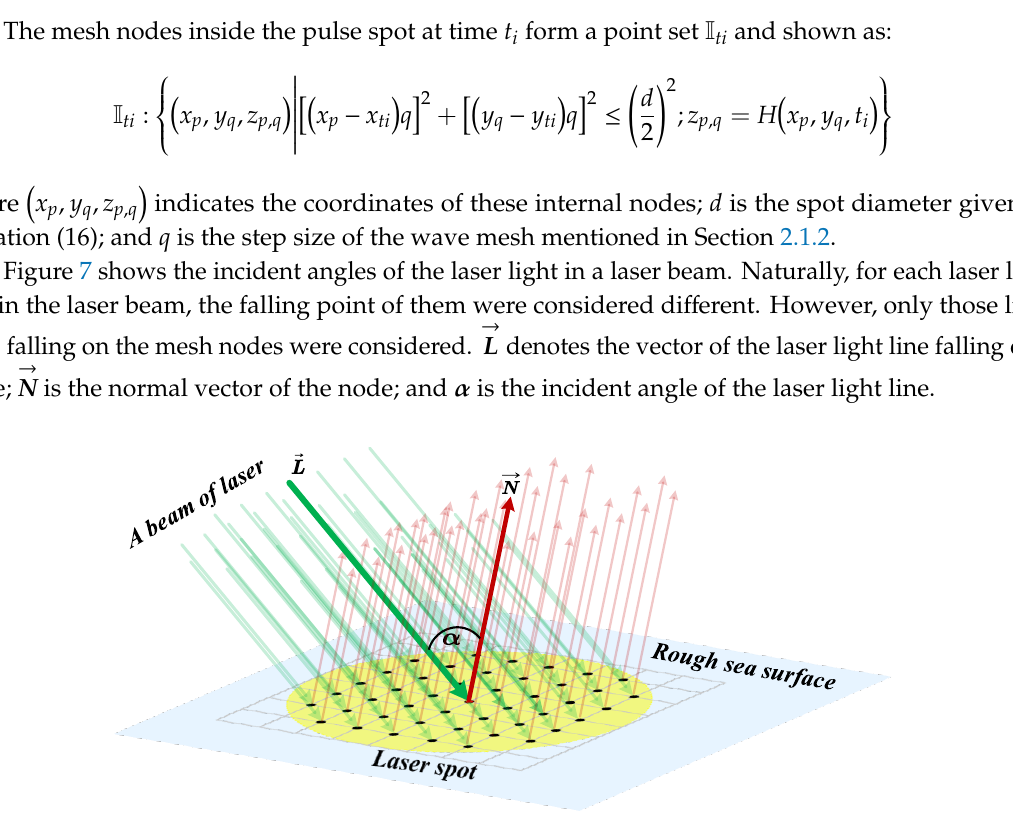
Figure 6. Mesh nodes inside the pulse spot.